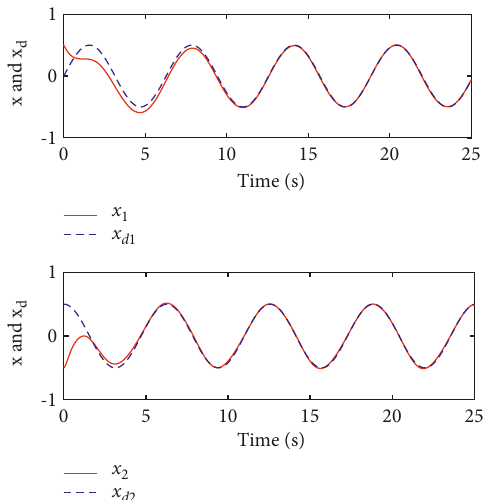
Figure 2: Tracking performance for uncertain system (44) with (34).